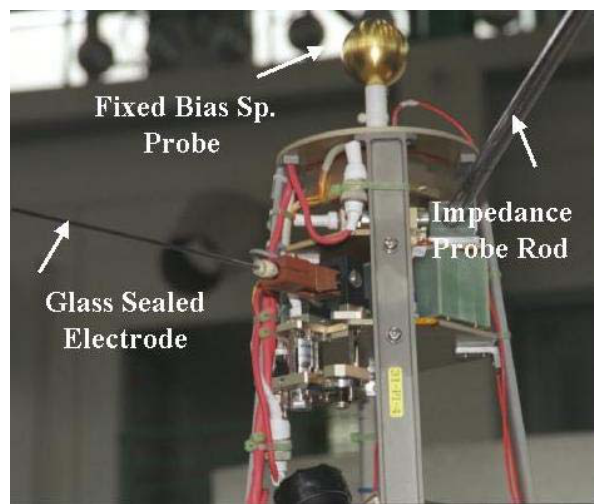
Fig. 2b. Deployed glass-sealed Langmuir probe, which is perpen- dicular to the rocket spin axis near the top of the payload section. A fixed biased spherical electrode to measure the height profiles of the relative electron density and an impedance probe to measure the absolute electron density are also shown. Fig. 2a. Location of glass-sealed Langmuir Probe (indicated as glass-sealed electrode in the figure), and two wire cutters. Glass tube of glass-sealed Langmuir probe is covered with adhesive tape, so that the pieces of the glass cylinder do not scatter when the glass tube is broken by the first squib (indicated as a wire cut 1 in the figure) at the end of the support rod, which is shown in Fig. 1. The second squib (indicated as wire cut 2 in the figure) releases the wire, which holds the glass-sealed Langmuir probe along the rocket axis.